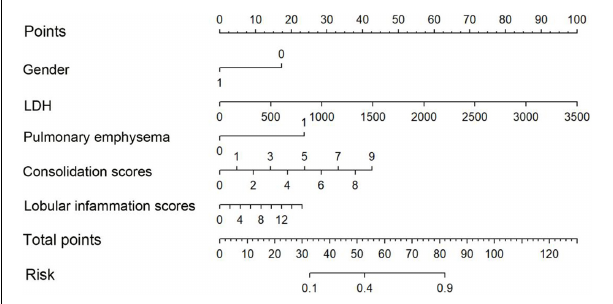
FIGURE 3 | Nomogram. To draw an upward vertical line to the “Points” bar to calculate points. Based on the sum, draw a downward vertical line from the “Total Points” line to calculate the probability of classification of adenoviral pneumonia patient. Male was denoted as 1, and female as